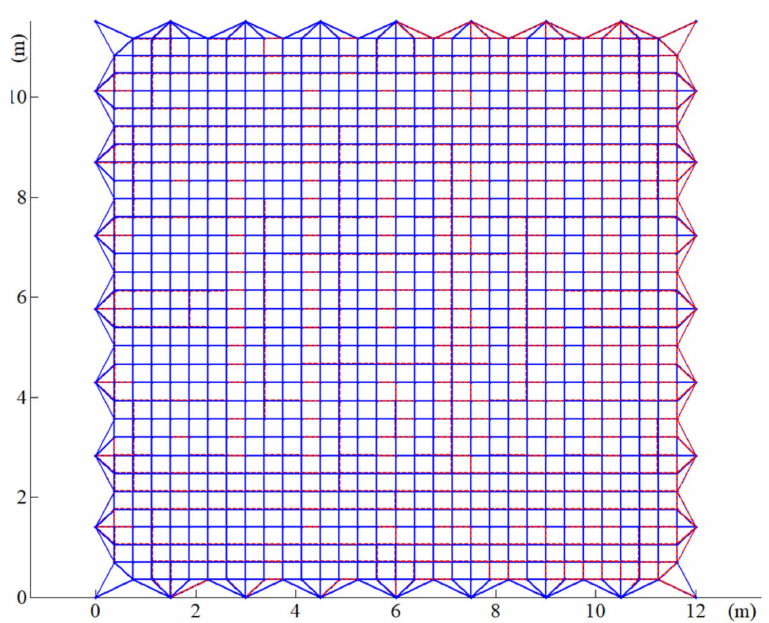
Figure 5. The result of form-finding analysis of a mesh reflector by the